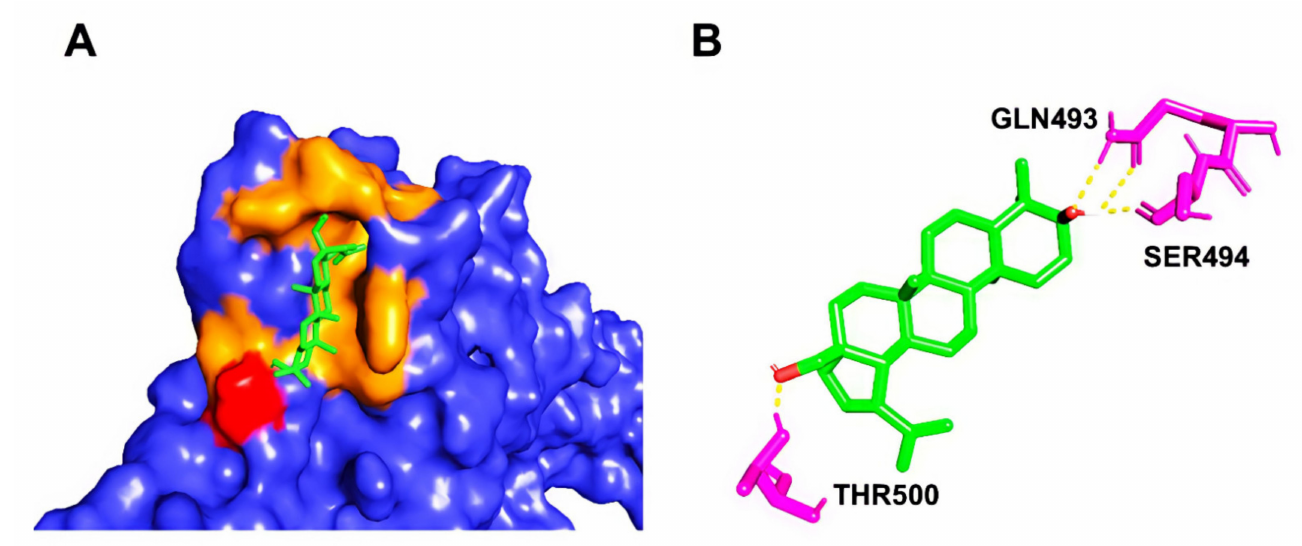
Figure 7. ( A ) Binding pose of the top-ranked phytochemical compound, Betulin, on the surface of Delta Spike RBD. ( B ) 3D view of the molecular interaction between Betulin and the residues inside the active site of wild-type SARS-CoV-2 S RBD. The yellow dashed line represents the hydrogen bond in the protein-ligand